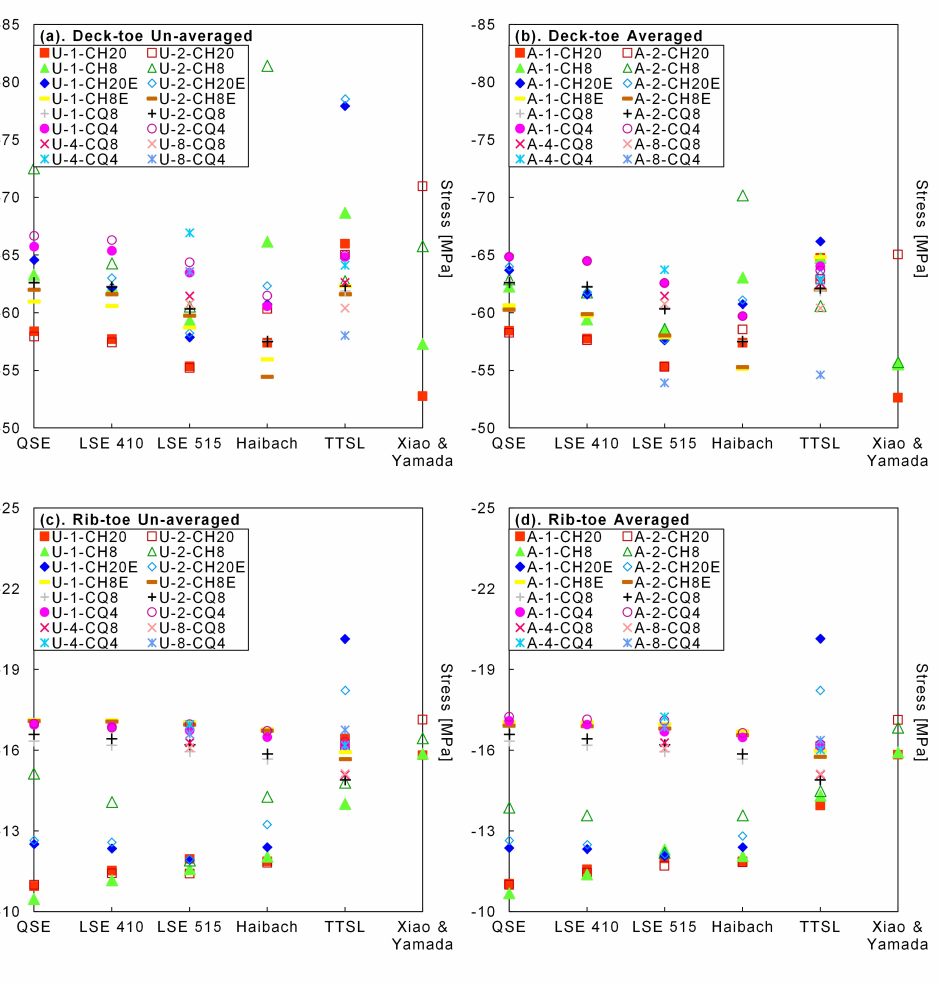
Figure 7. ( a – d ) Variation of SHSS evaluation methods for di ff erent meshing